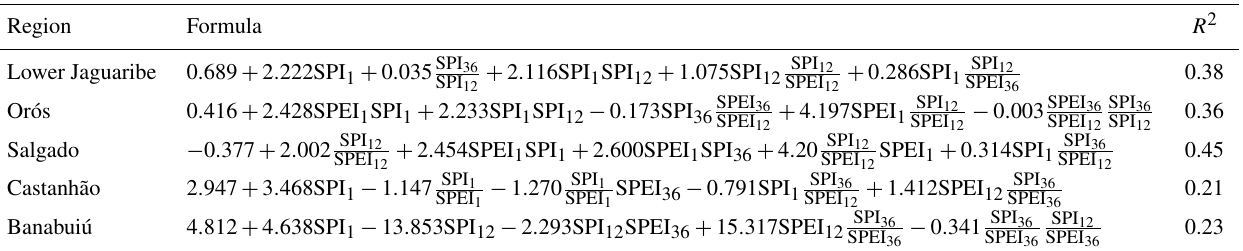
Table 2. Regional equations used for the calculation of monthly volume changes with the statistical approach. Table extracted and extended from Delgado et al. (2018b) (Table A1). For details and abbreviations see